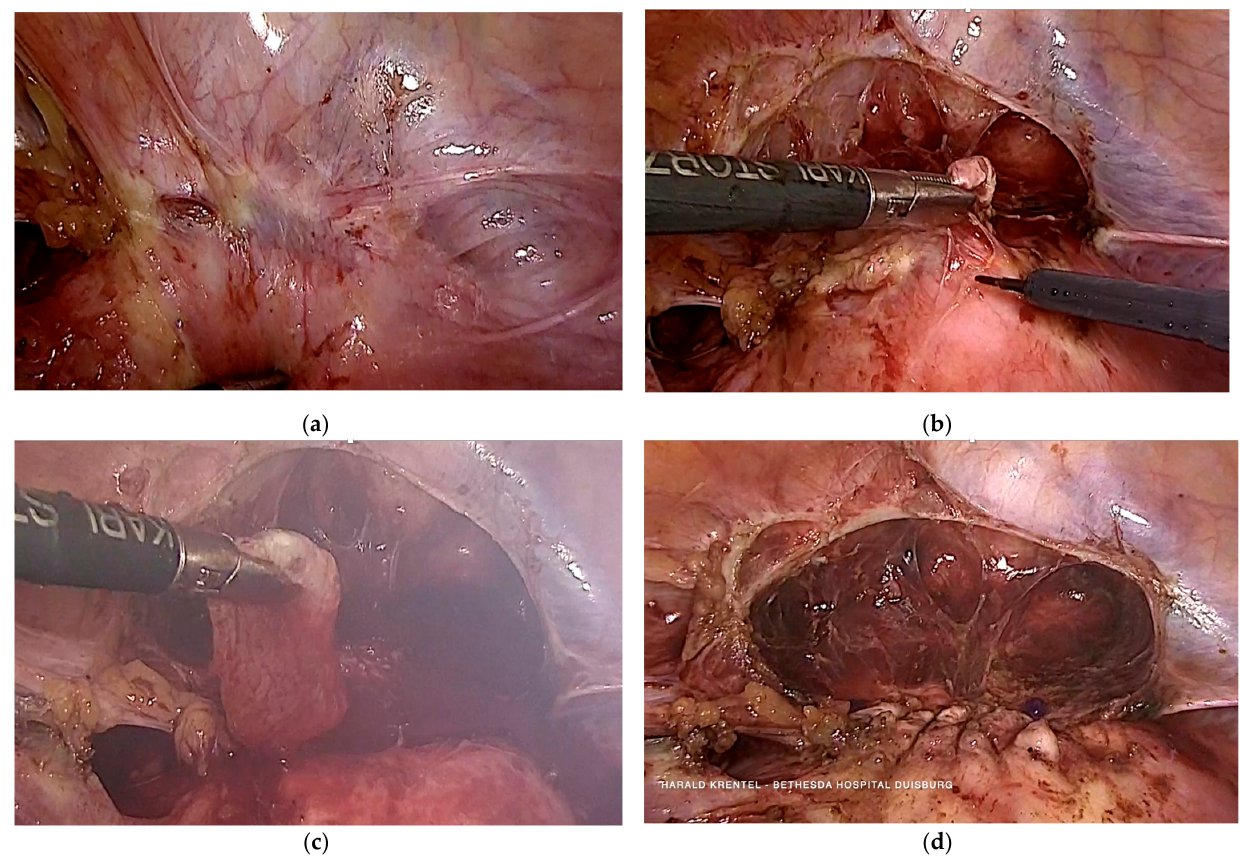
Figure 3. Laparoscopic treatment of niche pregnancy (7 weeks of gestation). ( a ) laparoscopic view of the uterine niche pregnancy; ( b ) laparoscopic resection of the uterine scar and niche pregnancy using a monopolar needle; ( c ) laparoscopic removal of the gestational sac; ( d ) laparoscopic view after double layer suture of the uterine wall.